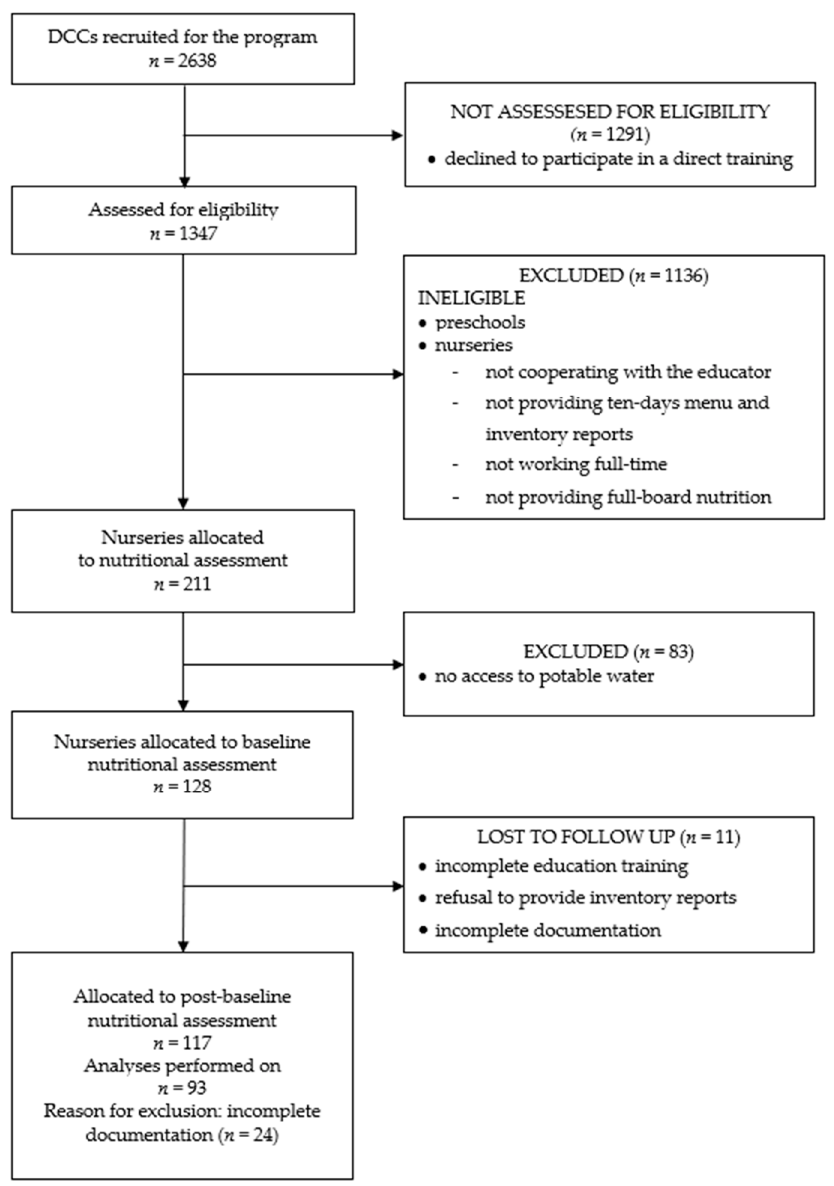
Figure 1. A scheme for selecting the sample of the study.